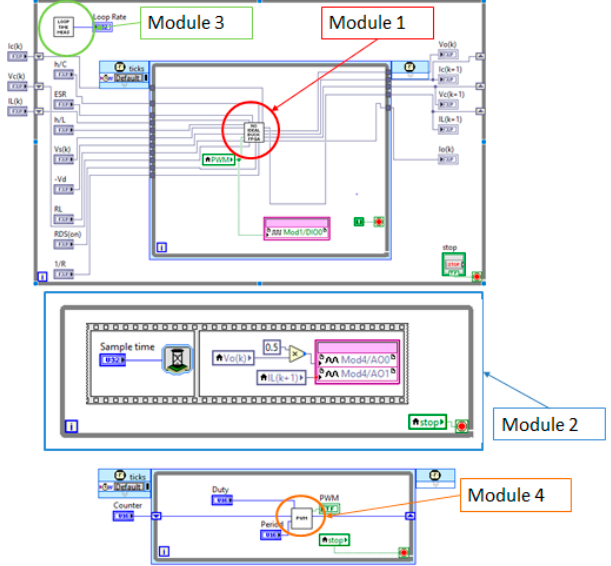
Figure 11. Program employed to obtain the clock cycles per iteration.